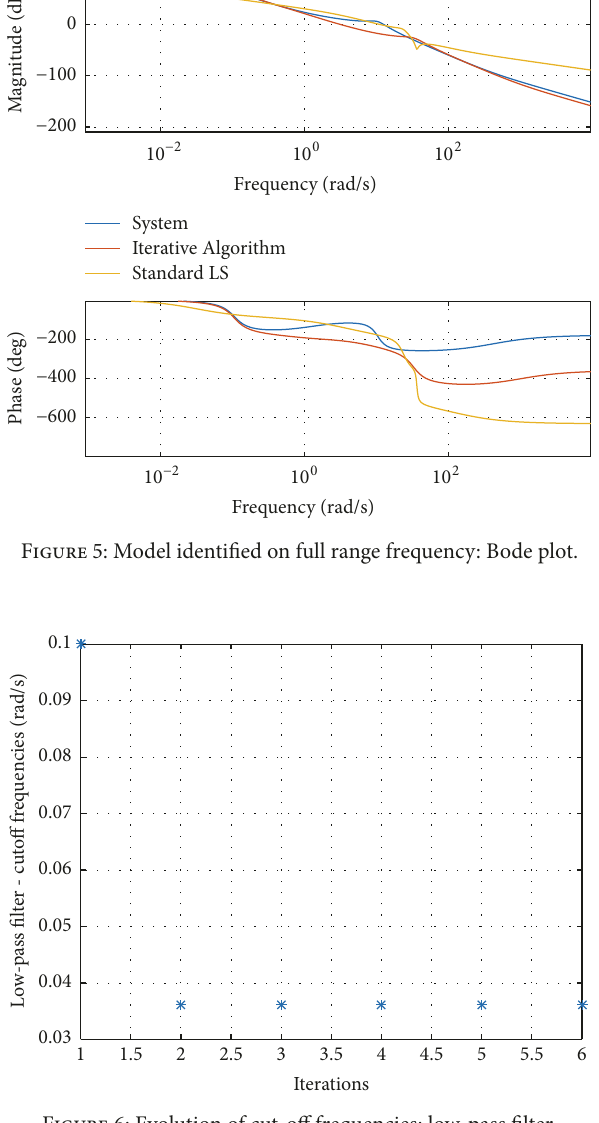
Figure 8: Comparison between identified models: horizontal- velocity deviation ( m . s −1